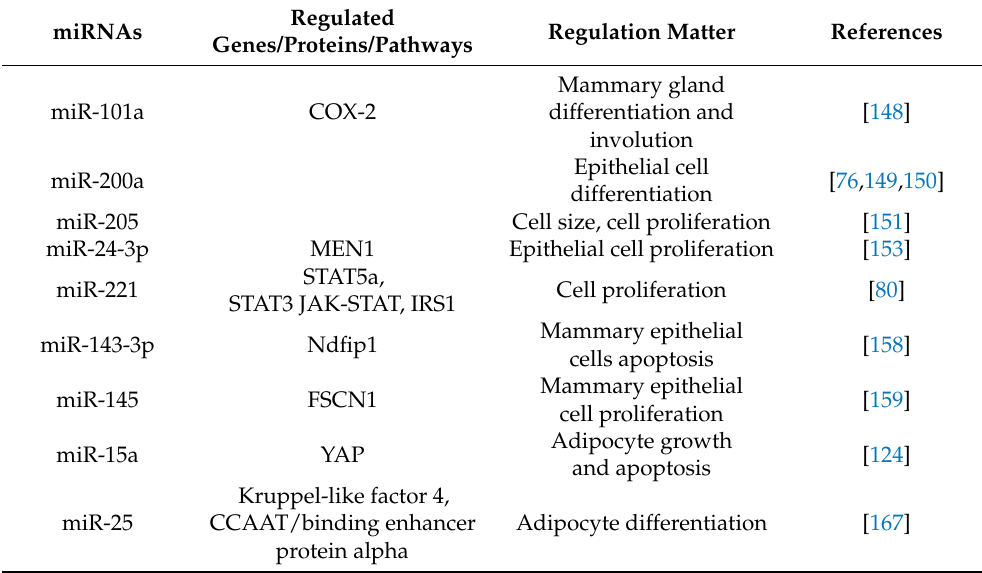
Table 7. A brief summary of the participation of some miRNAs in the cellular processes of mammary